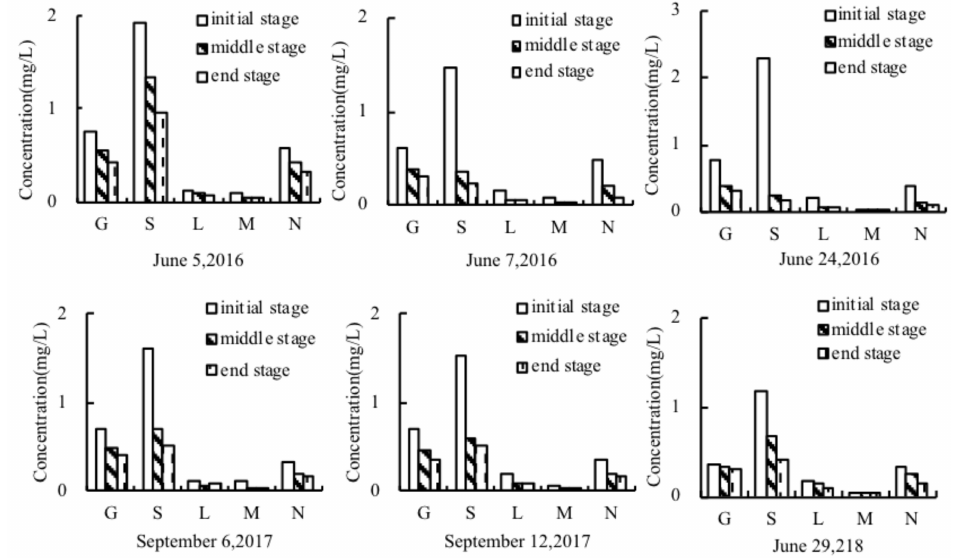
Figure 10. Observed soluble reactive phosphate concentration of the subsurface drainage